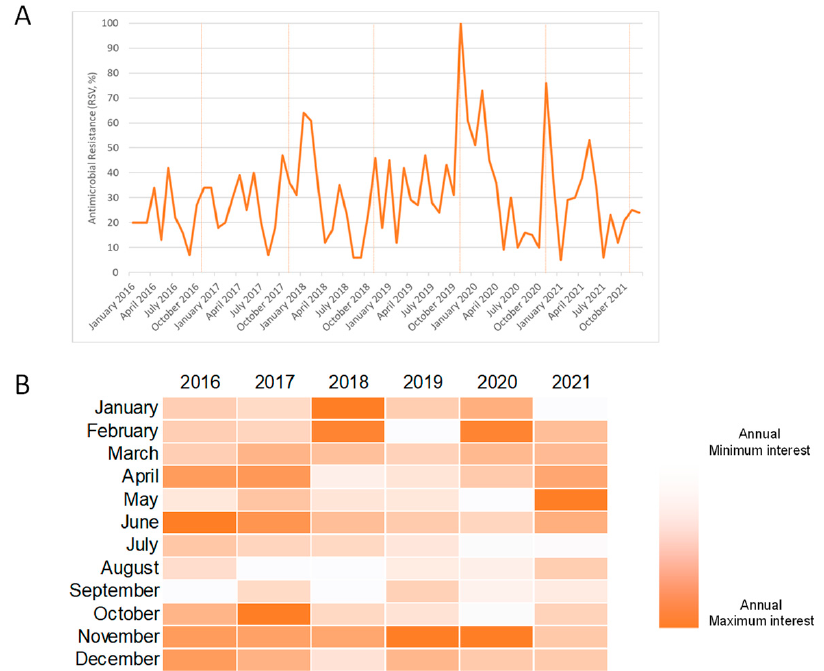
Figure 2. Public interest in the term “antimicrobial resistance” based on Google Trends data. ( A ) Relative search volume over time from January 2016 to December 2021. Vertical orange lines correspond to the months when WAAWs occurred; ( B ) heatmap showing the intensity of monthly public interest per